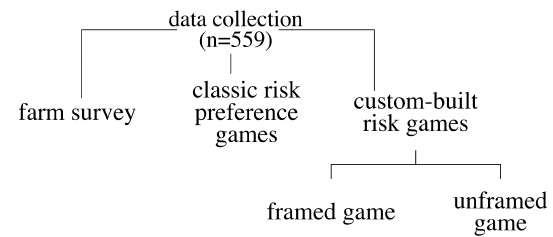
Figure 2. Survey Instrument. In 2014, we targeted recruitment of a sample of 600 producers farming properties of >500 hectares in Mato Grosso, Brazil. In total of 598 subjects participated in the experiments. Of this 598, just 559 were included in this analysis due to data collection errors. Data collection consisted of three components: a farm survey, a set of classic risk games, and custom-built risk games meant to emulate pasture to crop conversion